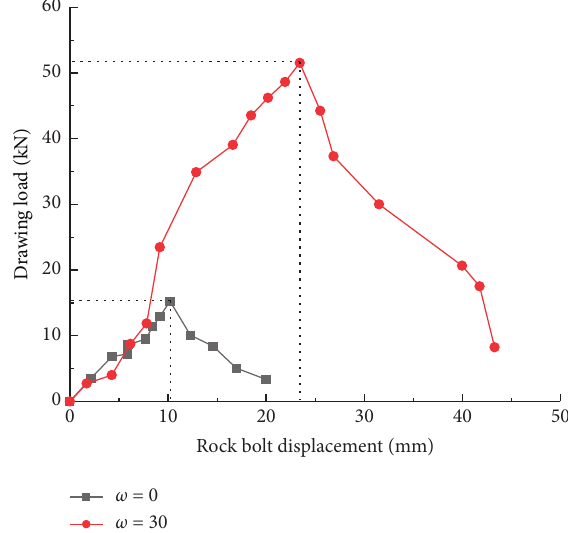
Figure 24: Load-displacement curve of the